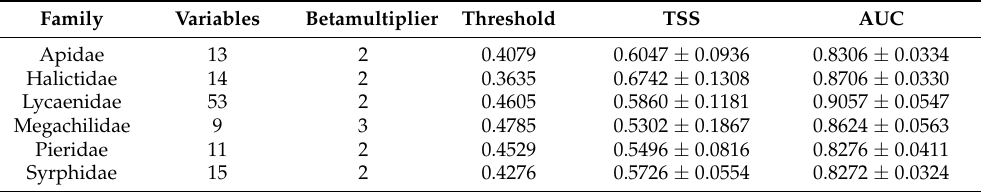
Table 1. Parameters and statistics for selected Maxent models of pollinator families. True skill statistic (TSS) represents the combined true positive and negative rates, while the area under the curve (AUC) represents the overall model